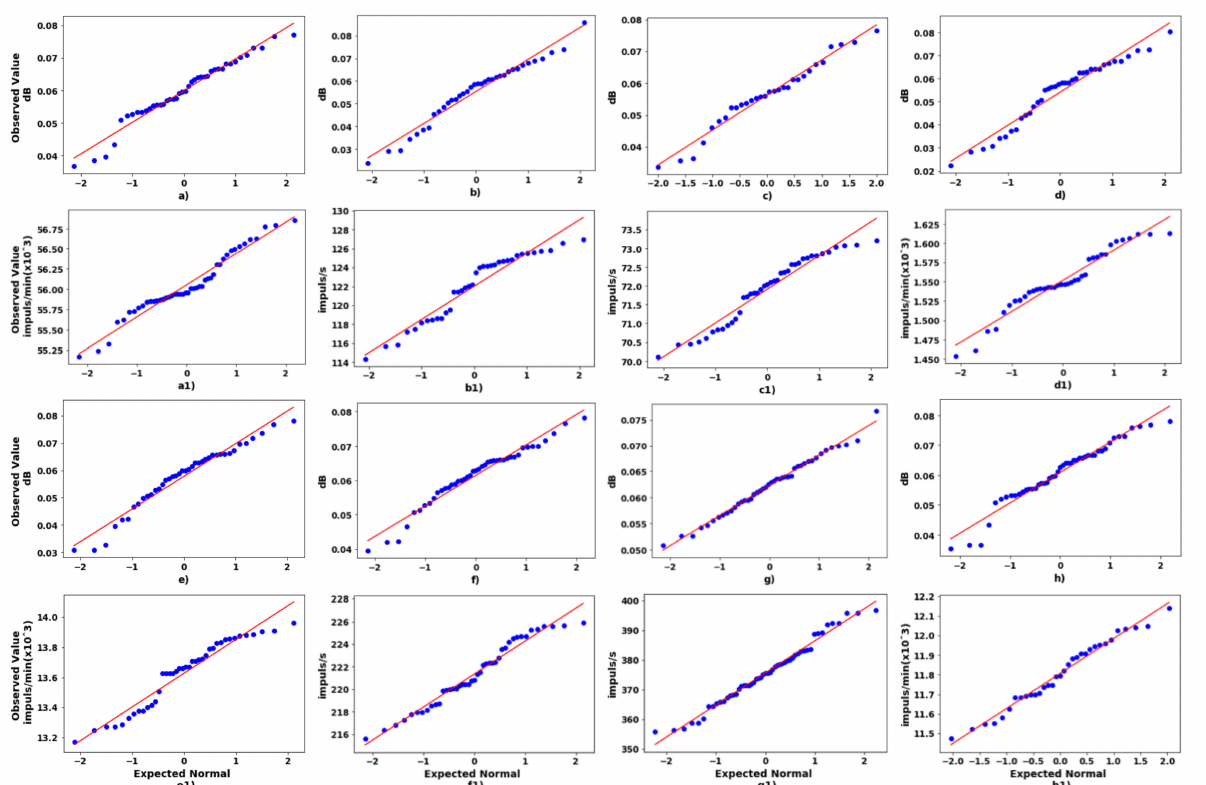
Figure 4. Q–Q scatter plots of monthly mean speckle values and cosmic ray number intensity data: ( a , a1 ) Athens (Greece), ( b , b1 ) Baksan (Russia), ( c , c1 ) Castilla–La Mancha (Spain), ( d , d1 ) Lomnicky_stit (Slovakia), ( e , e1 ) Mexico City (Mexico), ( f , f1 ) Nain (Canada), ( g , g1 ) NM64 NM Jungfraujoch (Switzerland) and ( h , h1 ) Tsumeb (Namibia). The graphs of variation and correlation coefficients of the two datasets obtained as a result of the Pearson correlation analysis performed for the data of all test areas are shown in Figure